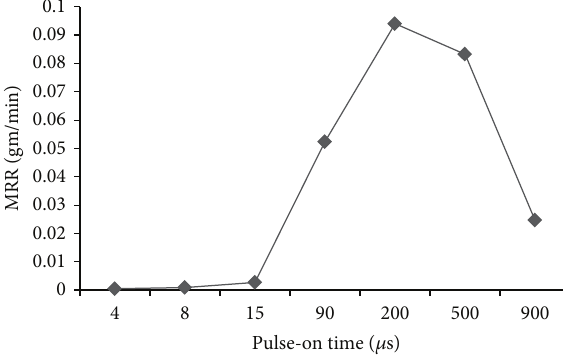
Figure 10: Influence of pulse-on time on MRR at constant current 9 Amp, gap voltage 60V, and pulse-off time 90 𝜇 s.